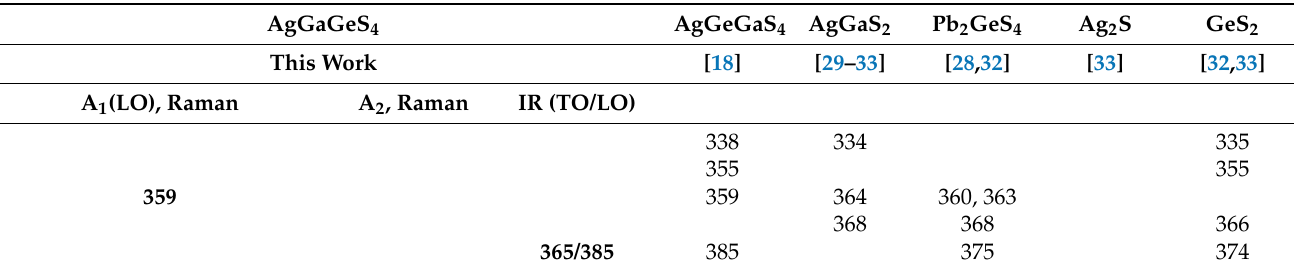
Figure 3. ( a ) Polarization-dependent Raman spectra of AgGaGeS 4 obtained at T = 300 K and  exc = 514.5 nm. ( b ) The effect of  exc on the first- and second-order (in the inset on the right side) Raman spectra.